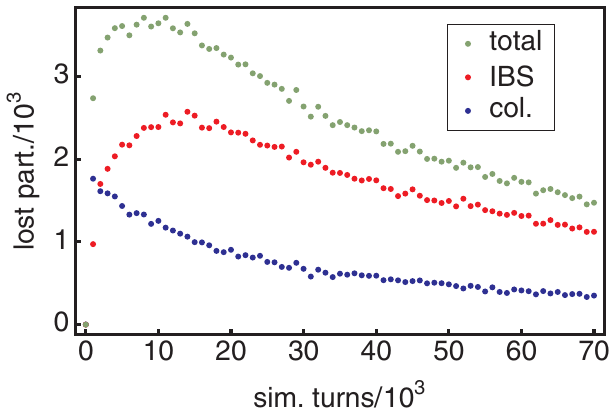
FIG. 7. (Color) The amount of macroparticles lost (integrated over 1000 simulation turns) due to IBS and collisions from bunch 1 (Blue) during the simulation of the test store 8908. In total 5 (cid:4) 10 5 macroparticles were simulated over 7 (cid:4) 10 4 turns, corresponding to a bunch population of 1 : 056 (cid:4) 10 9 and 5.26 h in the real